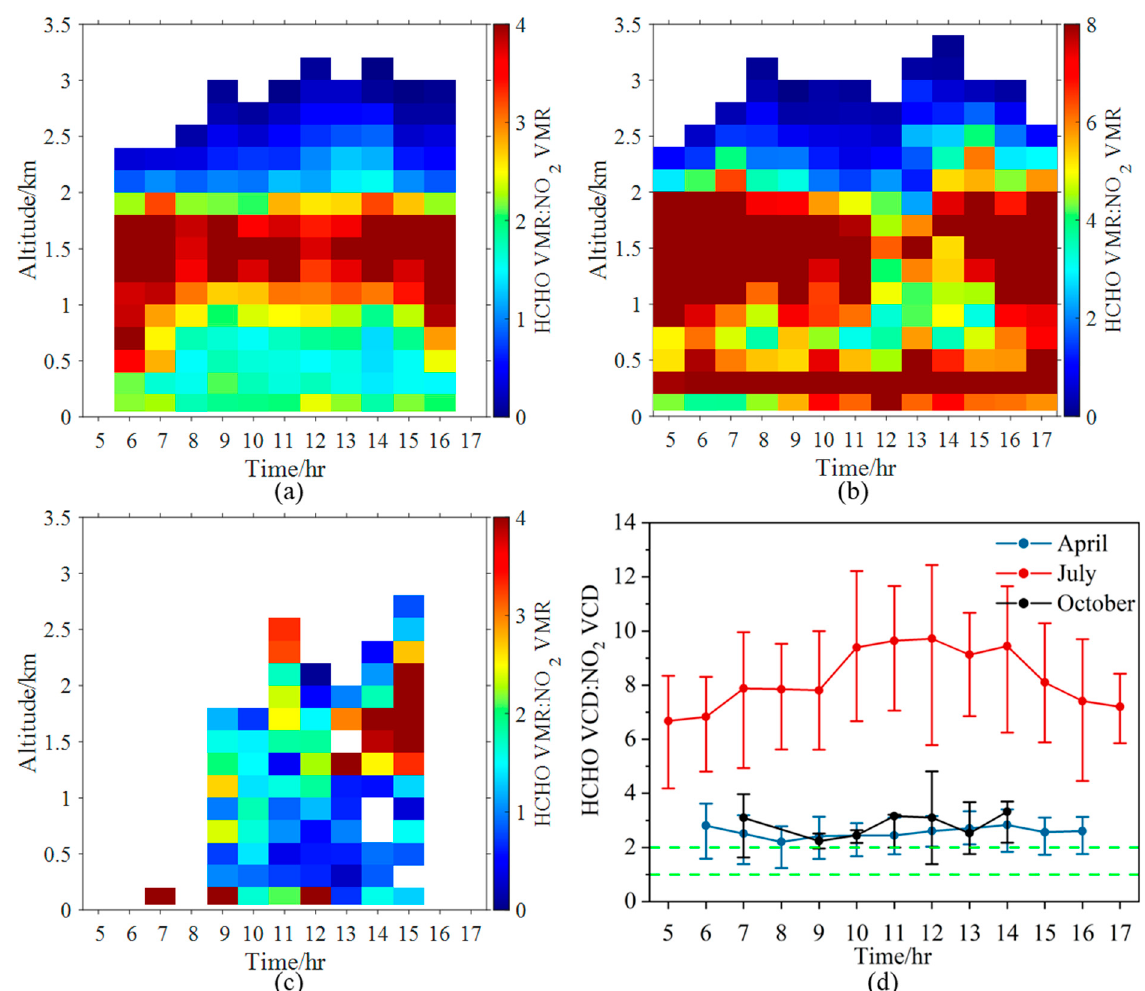
Figure 10. Diurnal variations in the vertical profile of the ratio of HCHO to NO 2 VMRs in ( a ) April, ( b ) July, and ( c ) October 2021. ( d ) Diurnal variations of RA VCD in April, July, and October 2021. The dots and error bars represent the averages and the 25th (75th) percentiles of the data grouped for each hour in April (blue), July (red) and October (black).